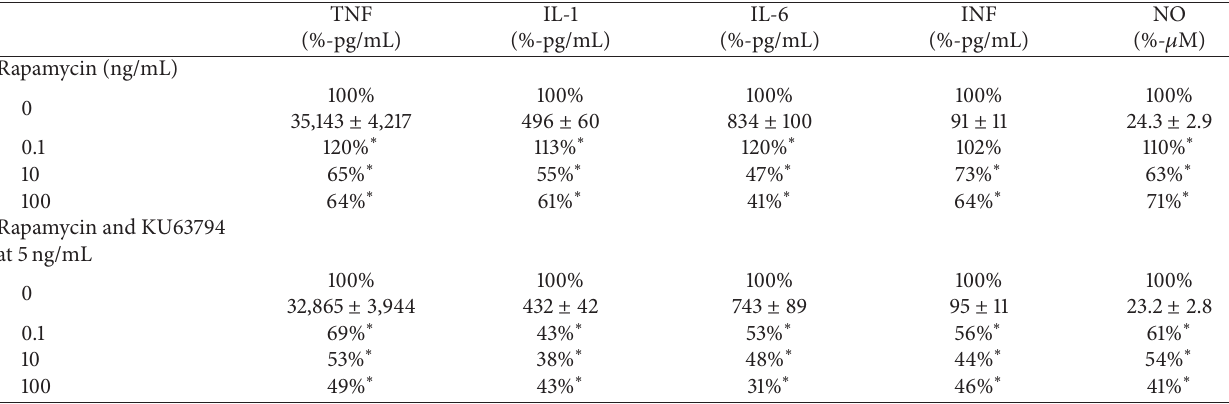
The first line indicates the response without Rapamycin (up) or without Rapamycin and KU63794 (down) which is used as control (100% response) and the subsequent values are expressed as % of such responses. ∗ Indicates statistical significance ( 𝑃 < 0.05 ) from the control.